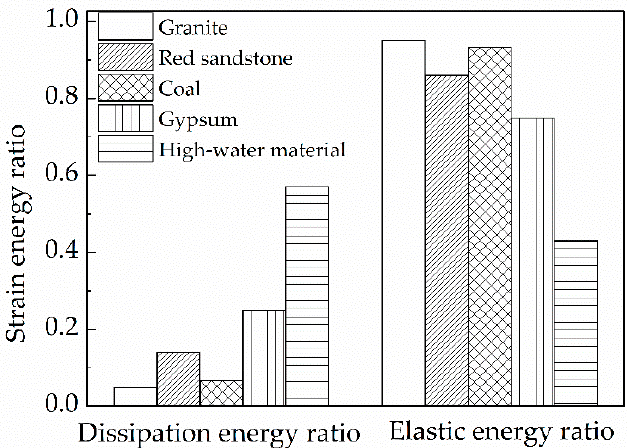
Figure 7. Evolution of the ratio of dissipated energy to total input energy for the rocks.